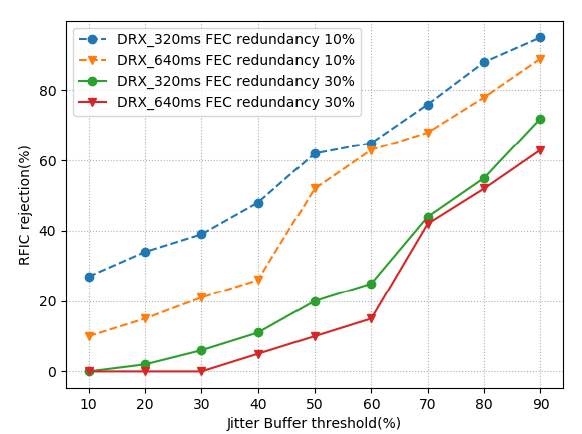
Figure 5. Simulation Results for allowable RFIC rejection as a function of Jitter Buffer thresholds